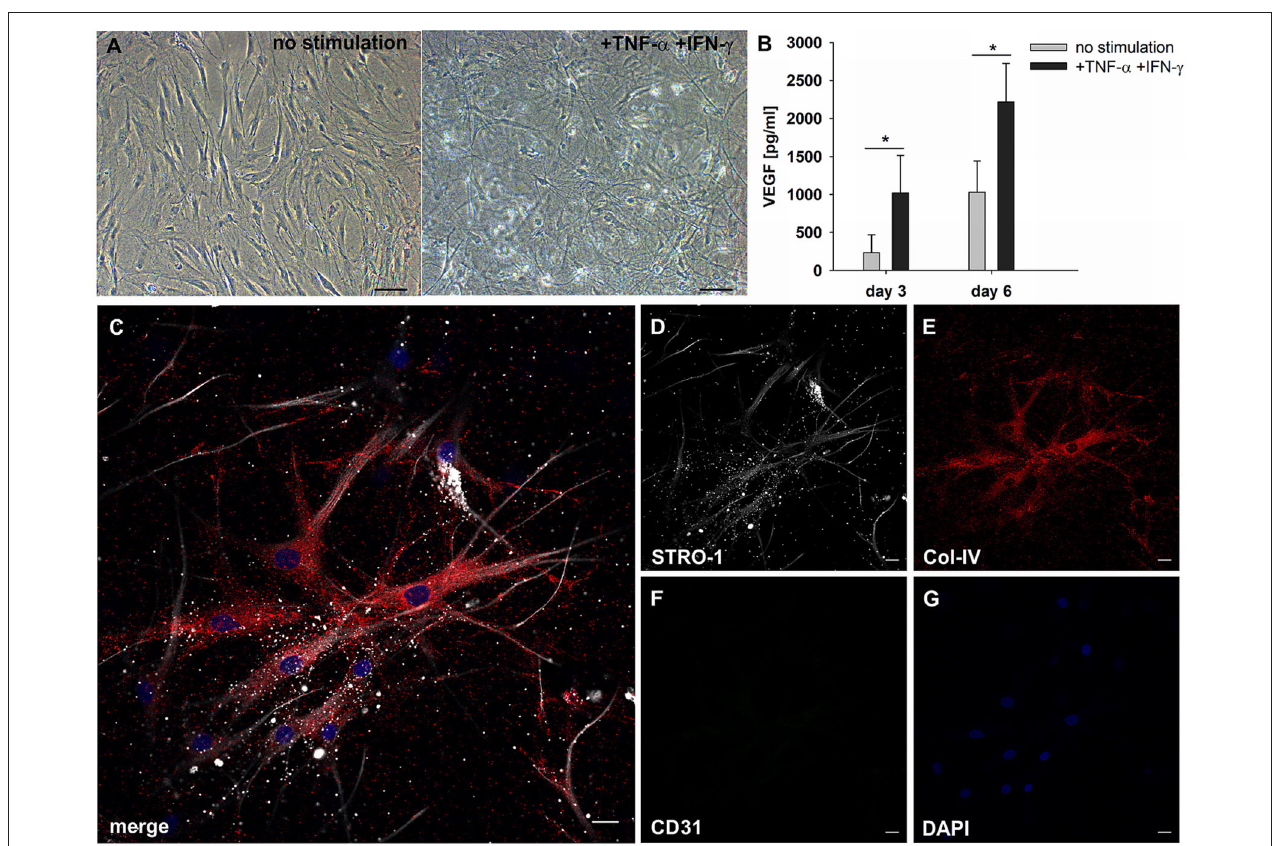
FIGURE 6 | MSC respond to inflammatory signals and develop filopodia. (A) Representative phase contrast images of bone marrow-derived MSC cultured in 3D fibrin matrices for 6 days. Unstimulated MSC with mainly spindle-shaped morphology, and TNF α /IFN γ -stimulated MSC showing multiple long cell protrusions resembling filopodia. Scale bars, 100 µ m. (B) VEGF secretion by unstimulated and stimulated MSC on day 3 and day 6 * p ≤ 0.05. (C–G) Representative CLSM images of MSC in 3D fibrin matrix with the addition of TNF α and IFN γ showing (D) STRO-1 expression in filopodia. (E) MSC produce Col-IV and (F) do not express CD31. (C) Merge. (G) DAPI stain. Scale bars, 20 µ